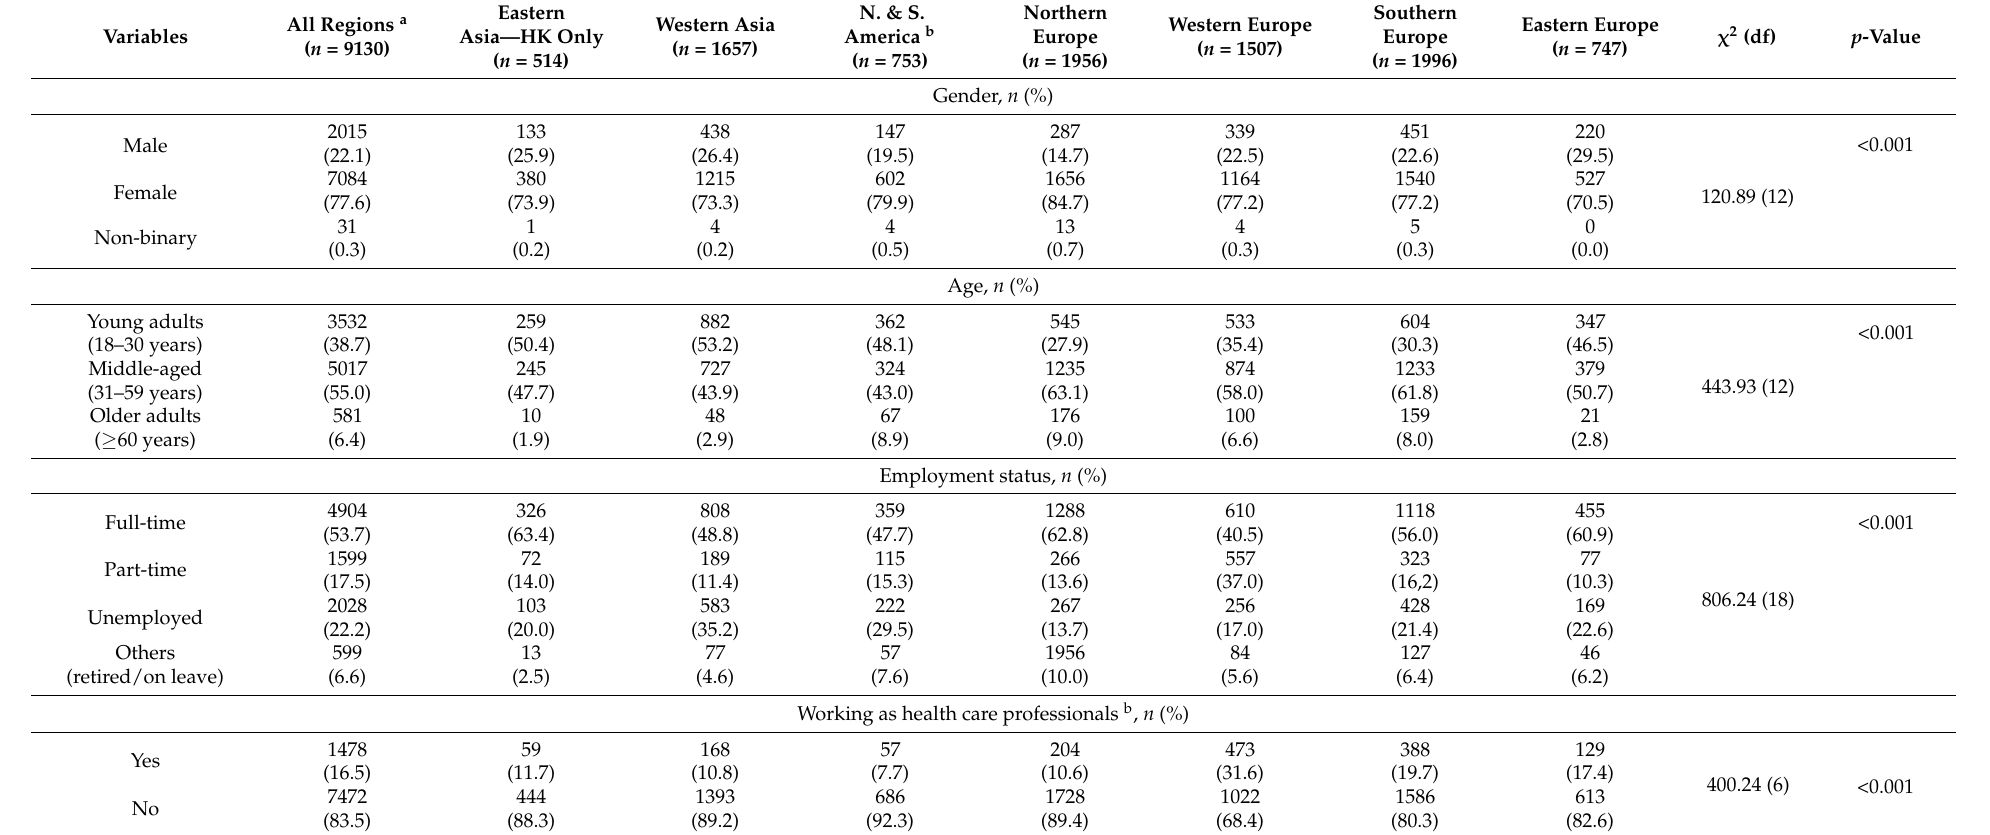
Table 1. Characteristics of the participants per